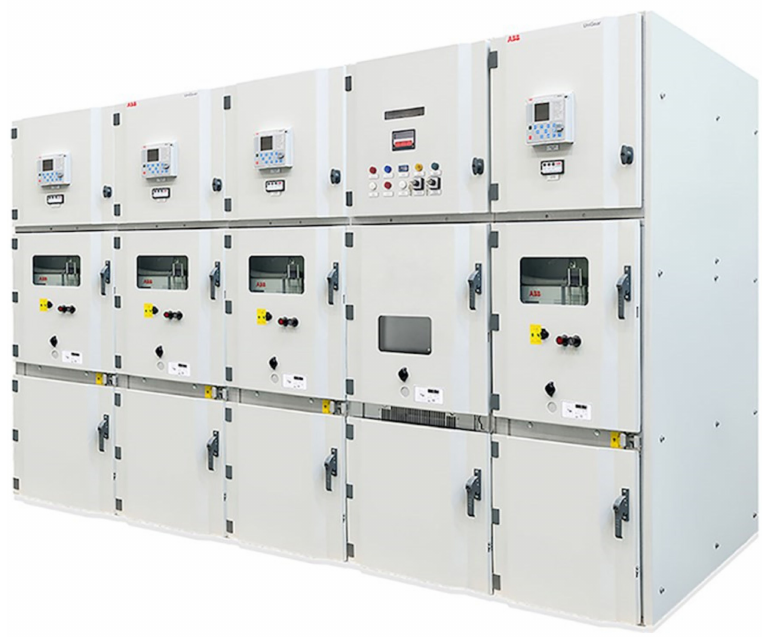
Figure 4. Medium voltage switchgear with five